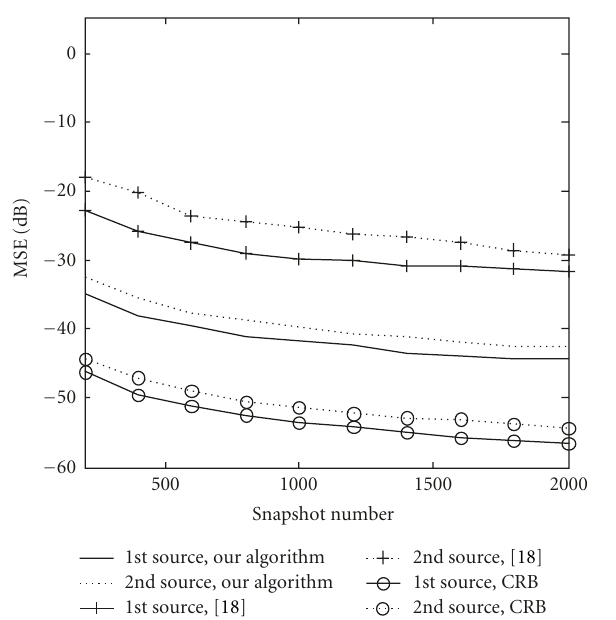
proposed approach requires neither pairing parameters nor searching spectral peaks, and can e ff ectively use the array aperture, and thus have higher estimation accuracy under the equivalent sensor